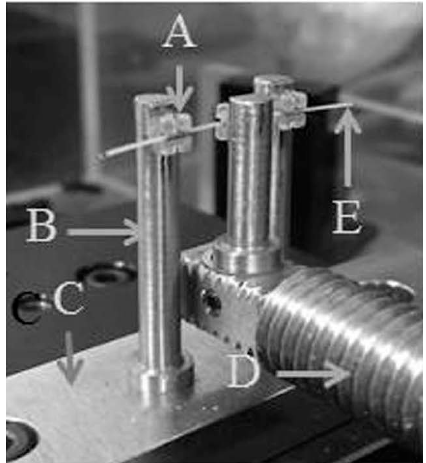
Figure 9. No ligation. A: bracket, B: rod, C: sensor linear gage, D: compression load cell, E: PEEK wire.